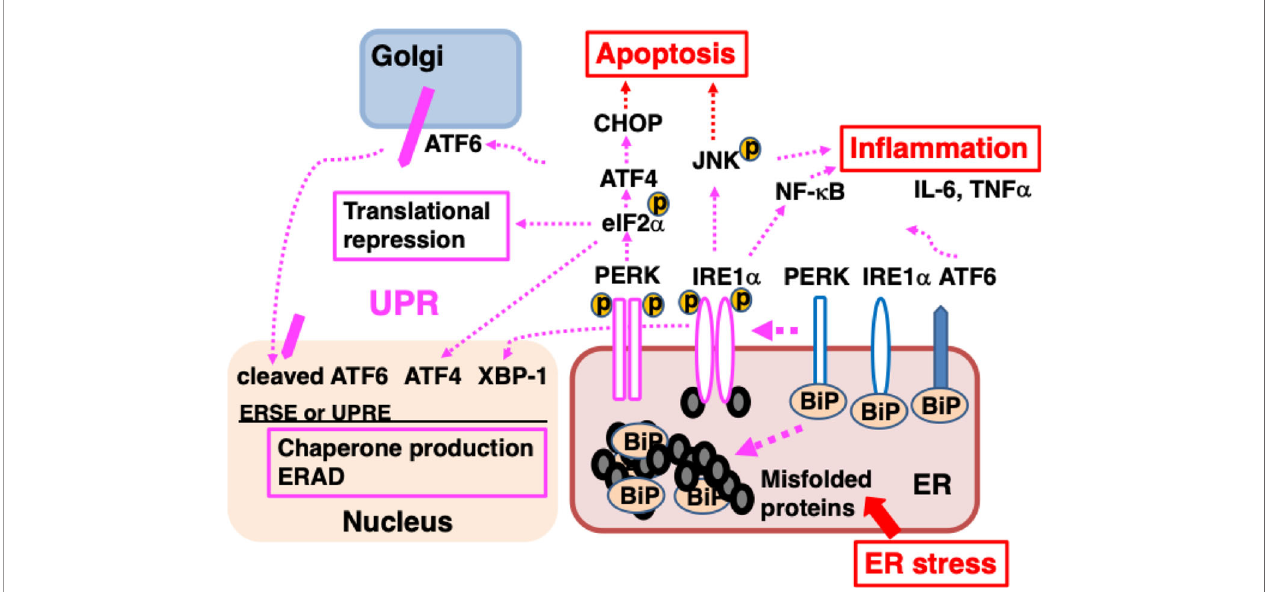
FIGURE 2 | ER stress causes the accumulation of unfolded proteins in the ER, inducing the unfolded protein response (UPR). Misfolded proteins accumulate in the ER when protein folding is disturbed due to ER stress such as intrinsic defects (e.g., mutated sequences, missing subunits) or extrinsic injuries (e.g., ischemia, malnutrition, hypoxia, and toxicity). BiP dissociates from ATF6, IRE1 a , and PERK, and associates with misfolded proteins; dissociation from BiP initiates the UPR. ATF6 is transported to the Golgi, where it is cleaved and the cytoplasmic portion of ATF6 is transported to the nucleus; there, it functions as a transcription factor, binding to ER stress response element (ERSE) and promoting the transcription of genes important for the UPR. After dissociating from BiP, IRE1 a , and PERK multimerize and are activated by autophosphorylation. IRE1 a is a type I membrane protein containing a serine/threonine kinase domain and an endoribonuclease domain at its cytoplasmic carboxyl terminus. Activated IRE1 a splices XBP1 mRNA. The XBP1 protein binds to UPR elements (UPREs) in the transcriptional region of various genes required for the UPR and promotes their transcription. PERK is a serine/threonine kinase that phosphorylates and inactivates eIF2 a , thereby halting the translation of most proteins. However, the translation of ATF4 is induced. ATF4 acts as a transcription factor. The UPR enhances the ability of cells to deal with increased levels of misfolded proteins through chaperone production, translational repression, and ER-associated protein degradation (ERAD). Activation of IRE1 a leads to in fl ammation through the activation of MAP kinases (JNK) and NF- k B, inducing elevated expression of pro-in fl ammatory cytokines, such as TNF a and IL-6. Persistent ER stress induces the expression of CHOP, leading to